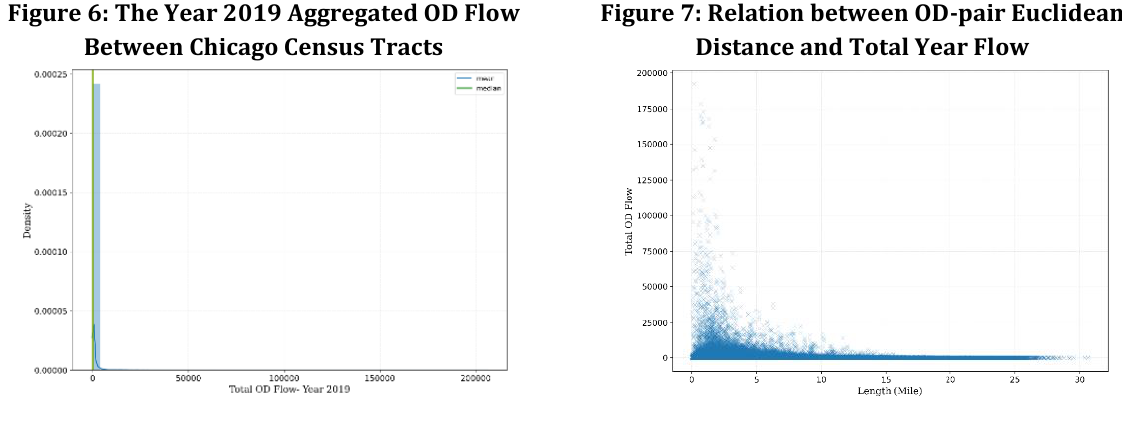
Figure 6: The Year 2019 Aggregated OD Flow Between Chicago Census Tracts